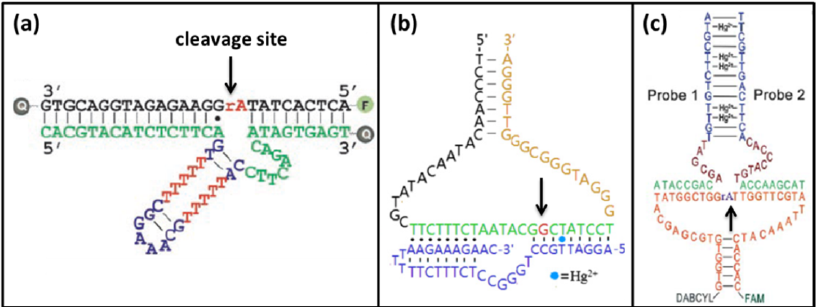
Figure 8. The structures and functions of modified DNAzyme for Hg 2+ detection. ( a ) modified UO 22+ -ion-specific DNAzyme; Reprinted with permission from [18]. Copyright 2007 Wiley VCH. ( b ) Cu 2+ -specific DNAzyme; Reprinted with permission from [85]. Copyright 2012 Elsevier. ( c ) Mg 2+ - specific DNAzyme. Reprinted with permission from [86]. Copyright 2012 Royal Society of